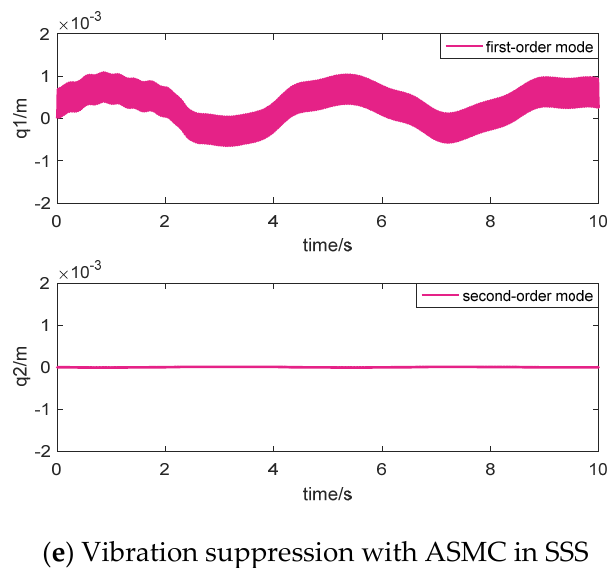
Figure 13. Comparison with the ASMC in SSS.